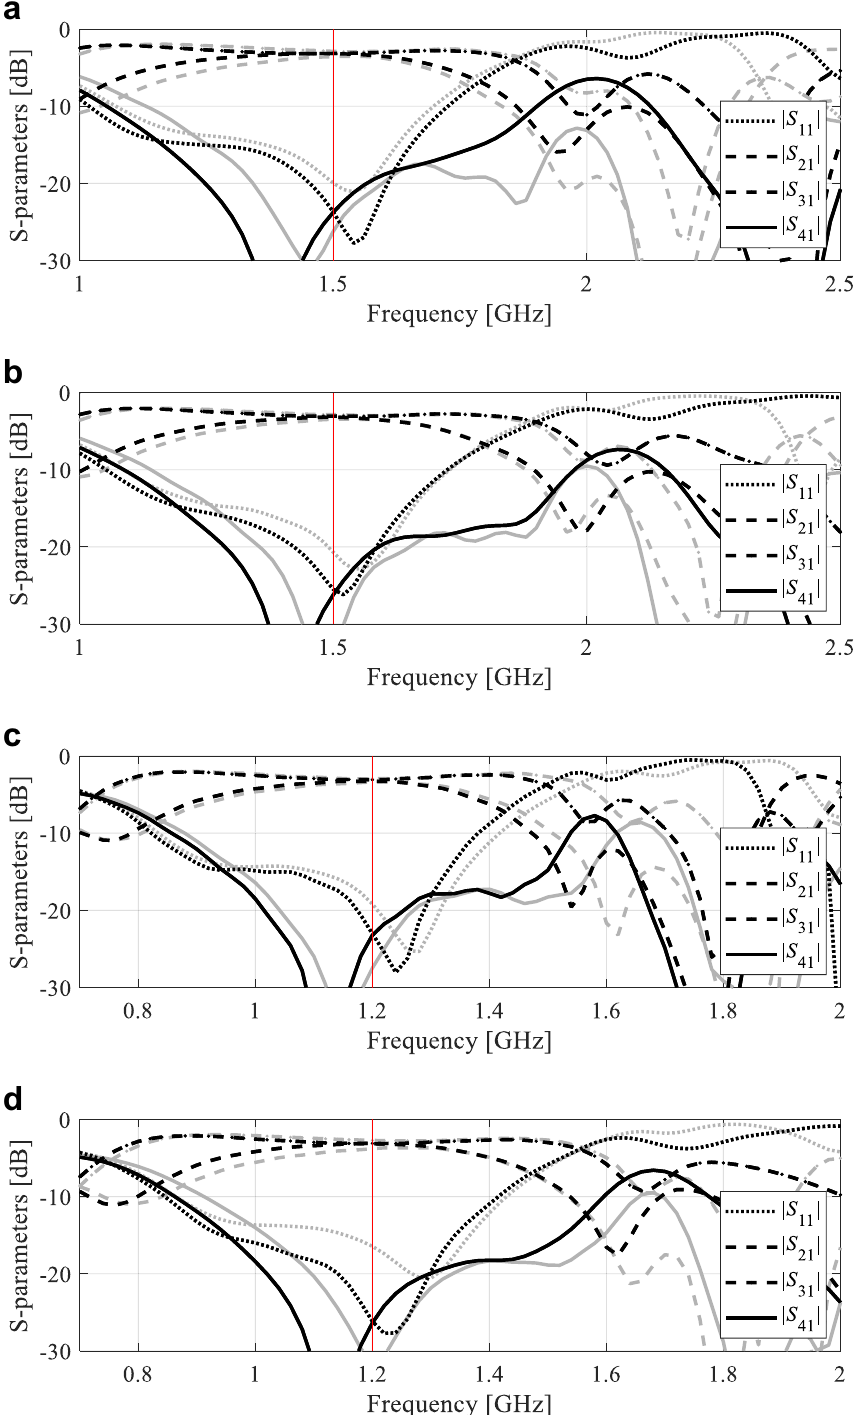
Figure 8. Circuit II: S-parameter characteristics at the optimized designs found by the proposed global optimization framework for two selected algorithm runs, Case 1: ( a , b ) Designs 1 and 2, respectively, Case 2: ( c , d ) Designs 1 and 2, respectively. Gray lines correspond to the initial design x (0) obtained using the global search stage, black lines represent the responses at the final design. Vertical lines mark the target operating